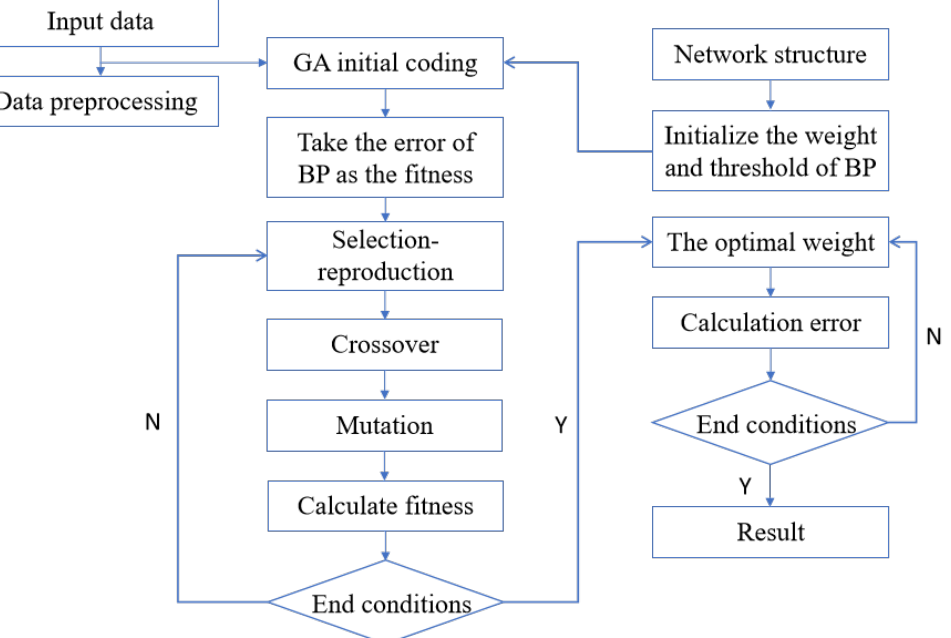
Figure 7. Neuron calculation method.